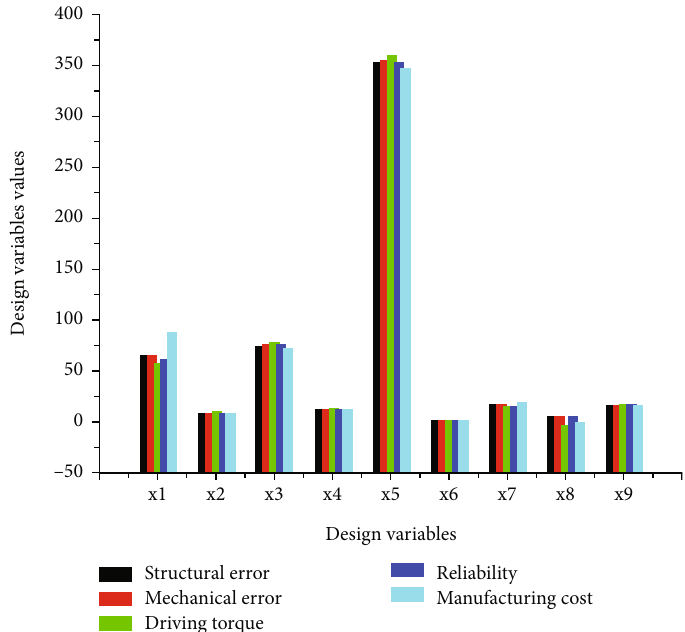
Figure 4: Optimal design variables versus individual optimization of thumb.